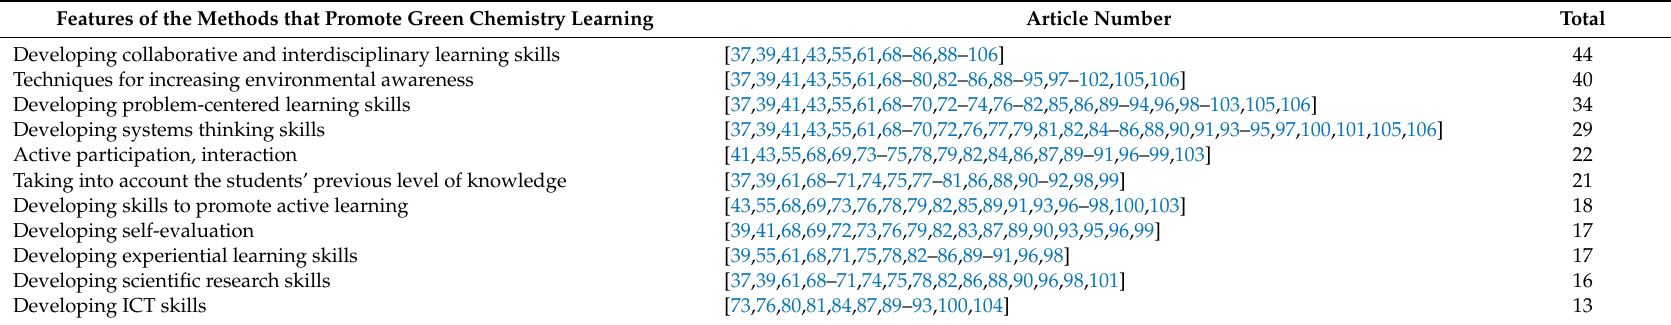
Table 4. The features of the teaching methods promoting green chemistry learning in the 45 articles